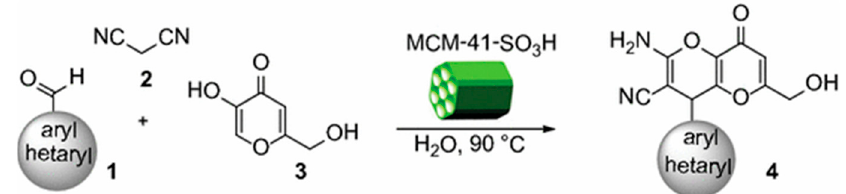
Figure 9. SO 3 H-MCM-41-catalyzed synthesis of 2-amino-dihydropyrano[3,2- b ]pyrane derivatives. Reproduced with permission from [20]. Copyright 2015 Springer.